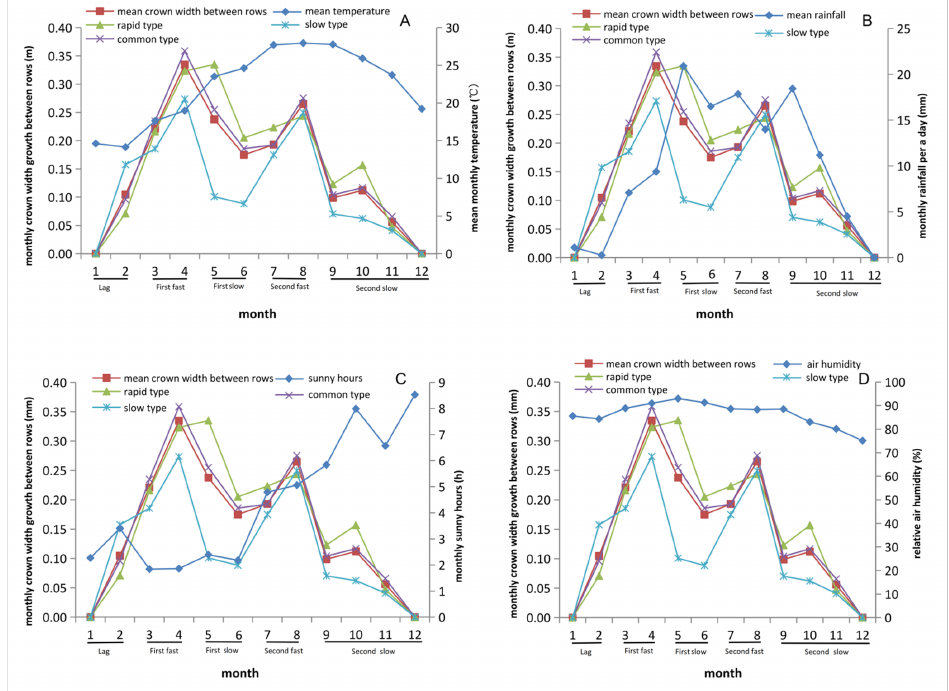
Figure 6. Dynamics of monthly crown width between rows and including temperature ( A ); rainfall ( B ); sunshine hours ( C ); and relative humidity ( D ). Meteorological data were supplied by Gaoming Meteorological Bureau, Foshan City, Guangdong Province, China.